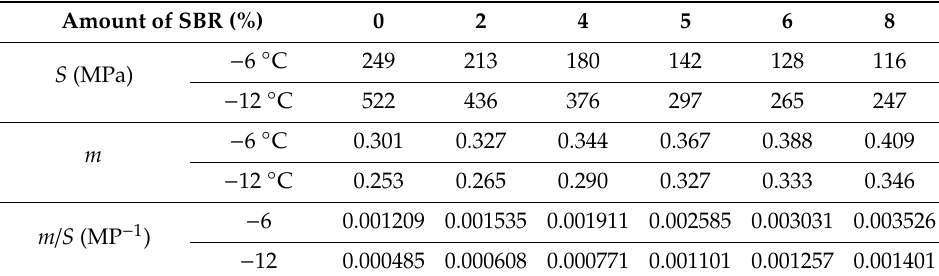
Table 19. BBR test results of BRA-SBR compound modified asphalt.